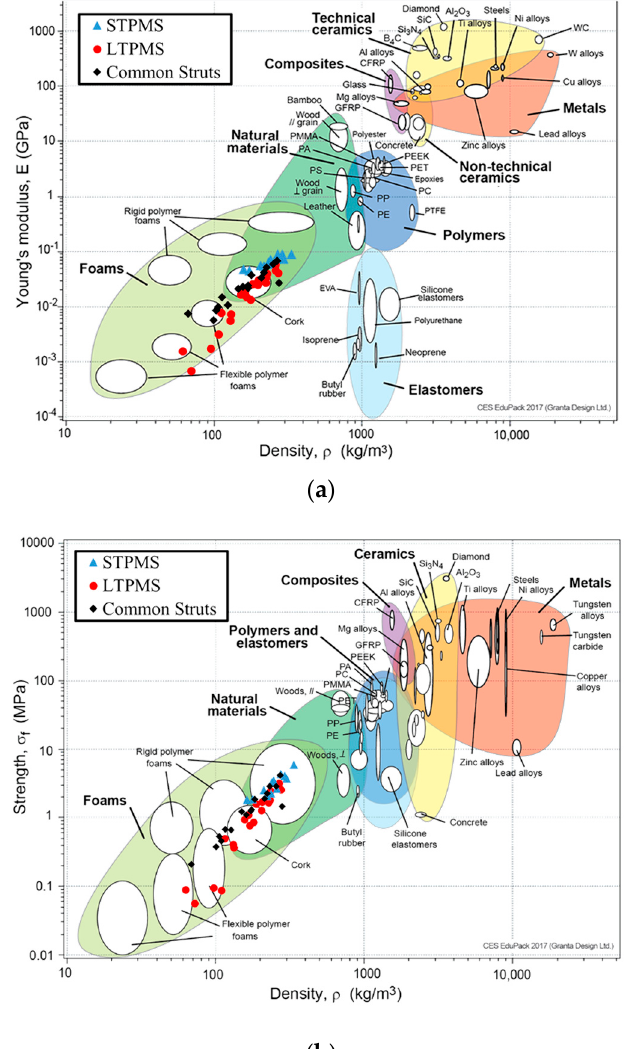
Figure 10. Ashby chart for different materials. ( a ) Young’s modulus versus density; ( b ) strength versus density (Generated by GRANTA EduPack software [92]).